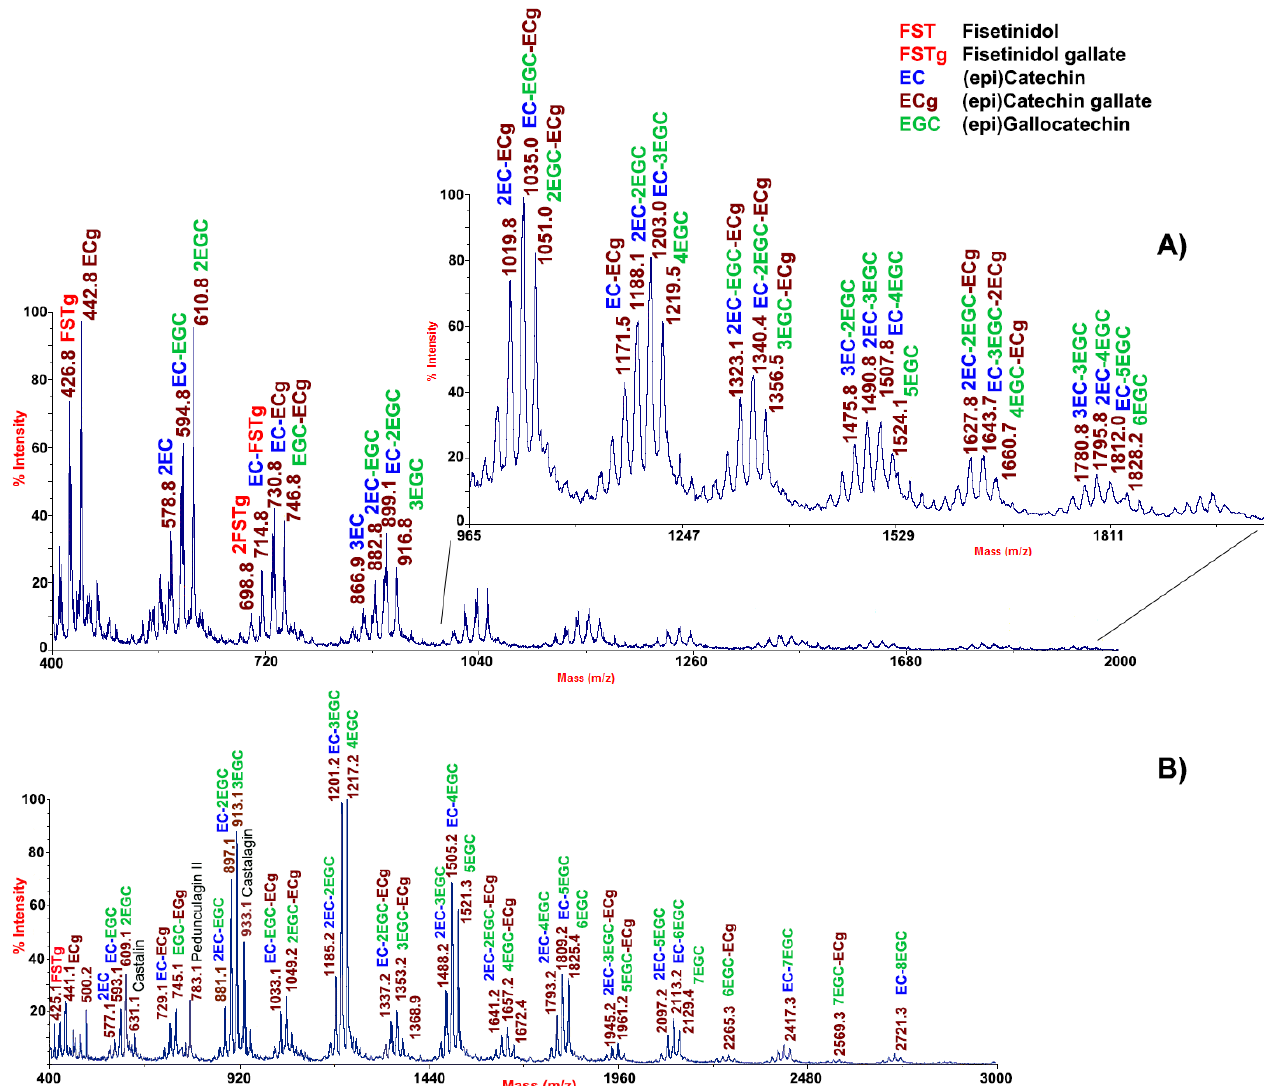
Figure 2. MALDI-TOF mass spectrum of the extract of chestnut integument tissues acquired in linear positive (panel ( A )) and negative (panel ( B )) ion mode. FST, fisetinidol; FSTg, fisetinidol gallate; EC, (epi)catechin; ECg, (epi)catechin gallate; EGC, (epi)gallocatechin.